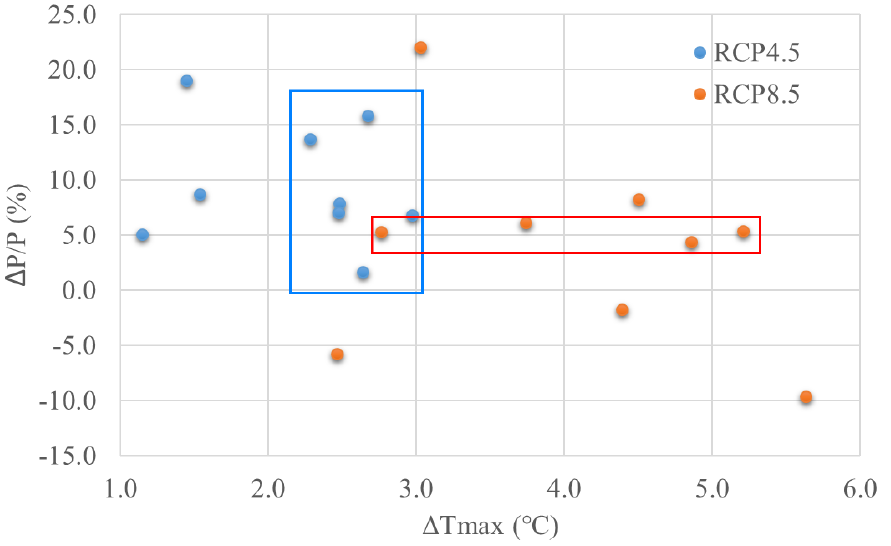
Figure 12. Projected relative changes (%) in average annual precipitation and delta changes ( ◦ C) in average annual mean daily maximum temperature for different GCMs and RCPs for the 2071–2100 period at station S06. The median value of the 100 realizations is shown for a given GCM and